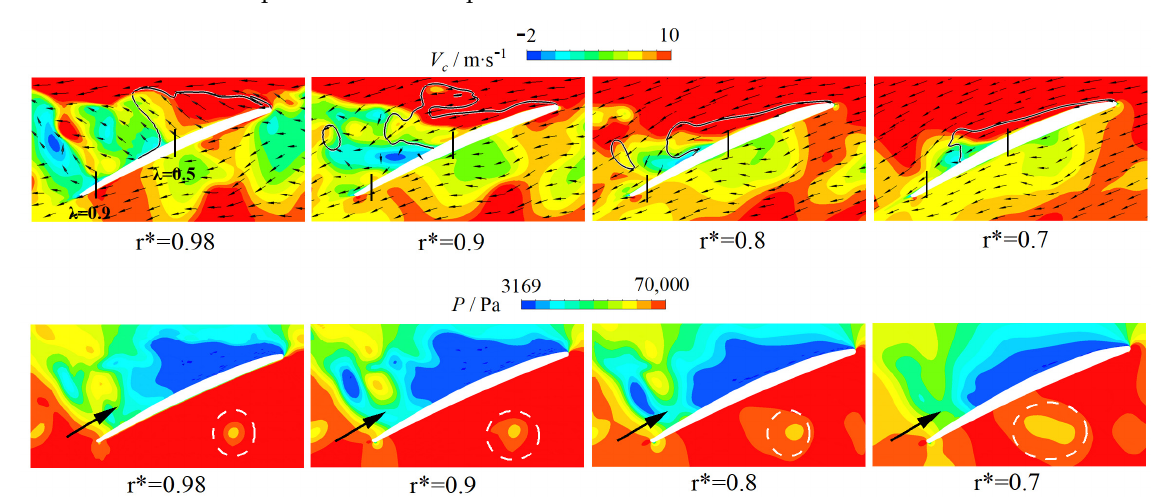
Figure 13. Distribution of circumferential velocity V c and pressure on radial sections (the solid line is the contour of the cavitation volume fraction α v = 0.1, Q = 0.8 Q BEP , σ = 0.35).